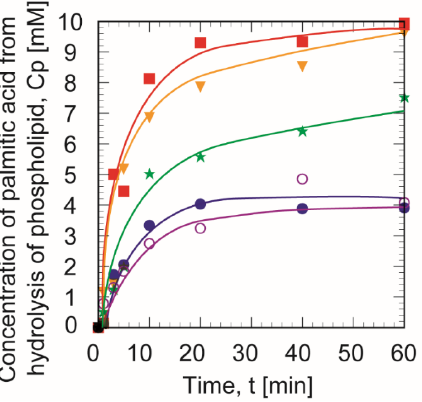
Figure 5. Time course of palmitic acid production (C p ) using immobilized phospholipase A 1 in various glutaraldehyde concentrations. The glutaraldehyde concentrations, C GA were 0% ( ○ ), 1.5% ( ● ), 3% ( ★ ), 6% ( ▼ ), and 10% ( ■ ). The experiments were each conducted a minimum of three times.